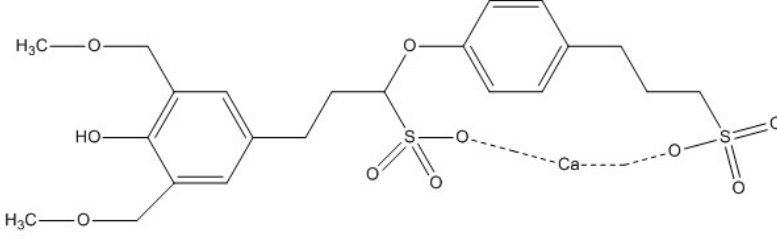
Figure 14. Chemical structure of calcium lignosulfonate (CLS).